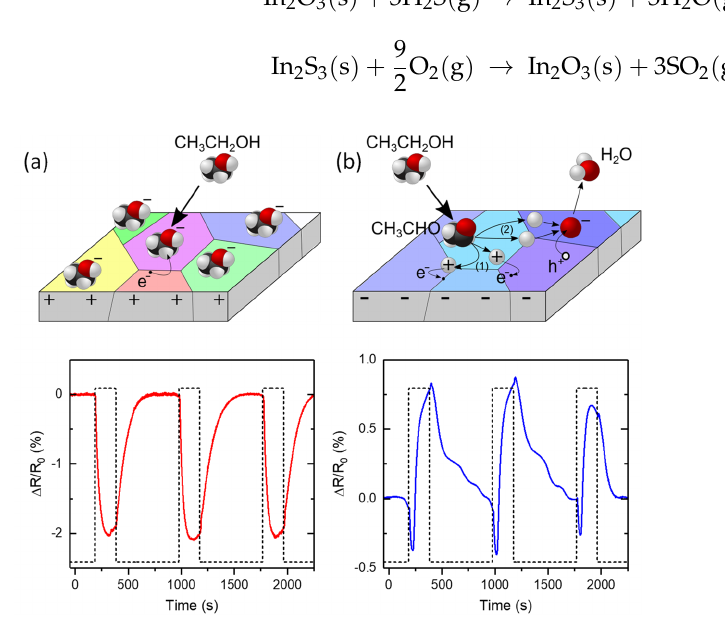
Figure 6. Opposing sensing mechanisms of NiO towards ethanol analyte at room